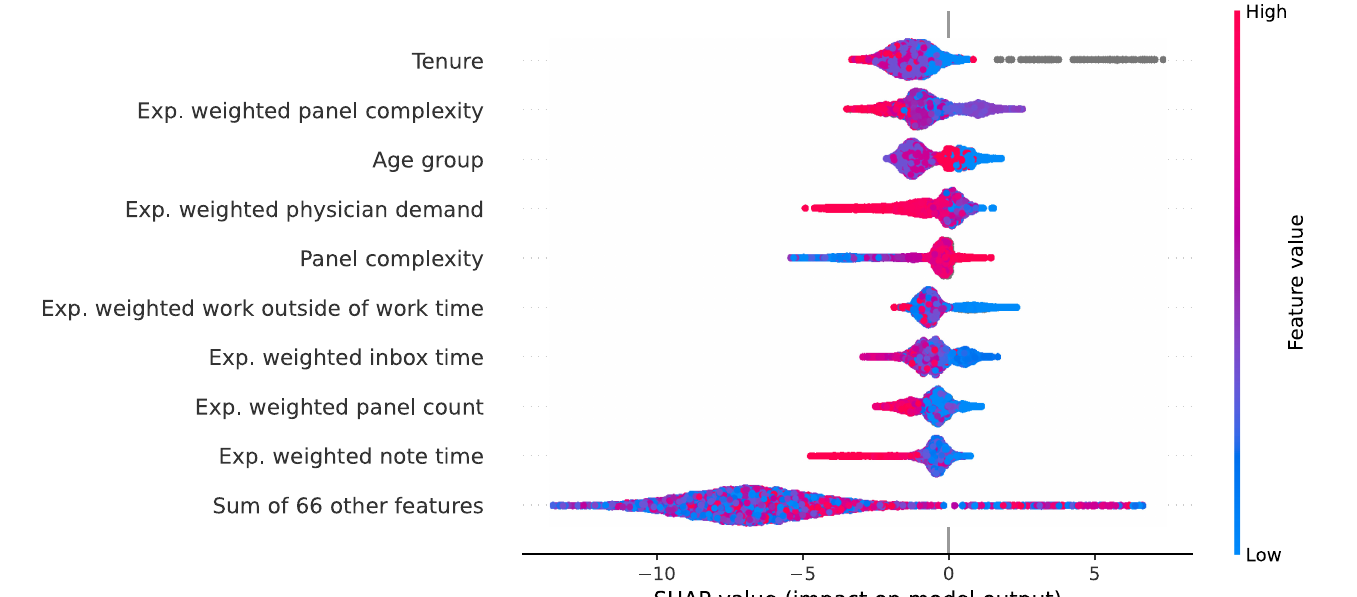
Fig 2. Shapley Additive Explanations (SHAP) analysis Beeswarm Plot showing the 10 top features contributing to physician departure. Each dot represents a physician-month. Positive SHAP values (right of 0.0 vertical line) indicate the feature increased the individual physician’s monthly risk of departure. Actual feature values are color-coded with high feature values indicated in red, low values in blue and null values in gray.